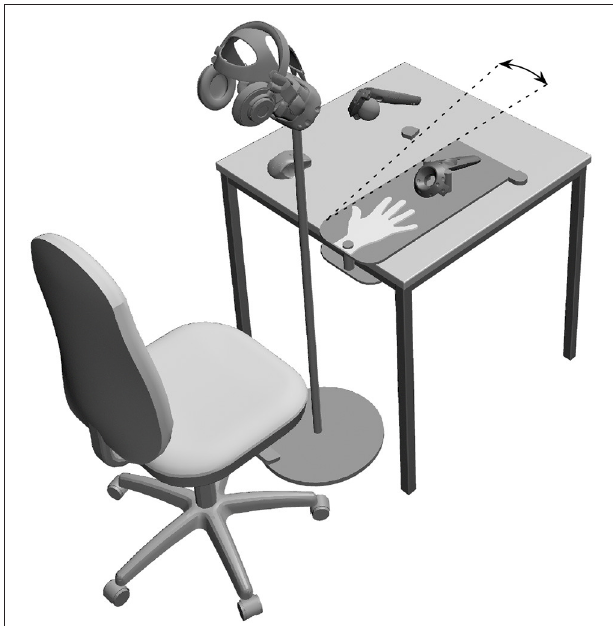
FIGURE 1 | Apparatus. We presented visual stimuli in a immovable head-mounted display. Participants placed their right hands on a hand rest. The experimenter delivered visuotactile stimulation with a styrofoam ball attached to a position sensor. The experimenter delivered visuomotor stimulation by rotating the hand rest. A sensor tracked the position of the hand rest. We presented Brownian noise in